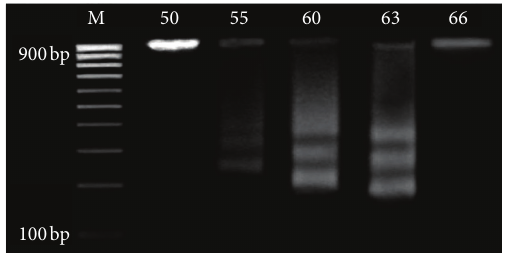
Figure 7: Agarose gels showing evident variations of the DNA fragmentation in extracts from the whole small intestine of stages 50 (Lane 2), 55 (Lane 3), 60 (Lane 4), 63 (Lane 5), and 66 (Lane 6), M